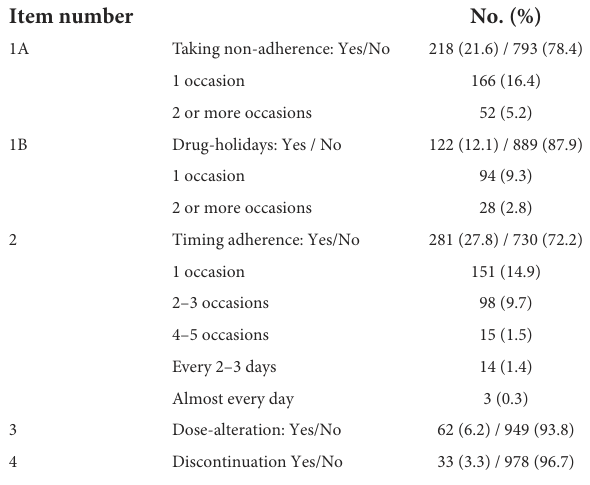
TABLE 2 Adherence to IM measured by